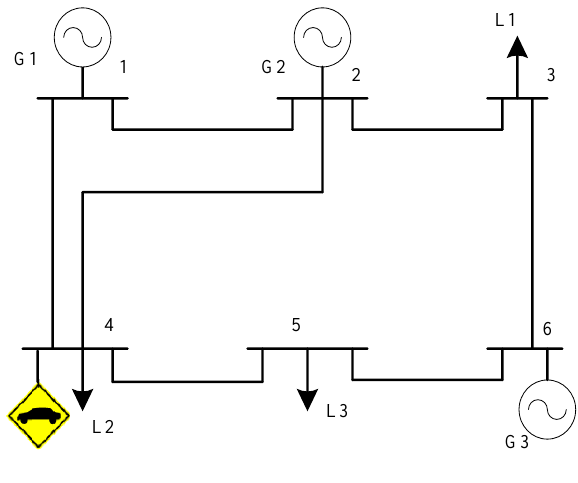
Figure 1. IEEE 6-bus test system.